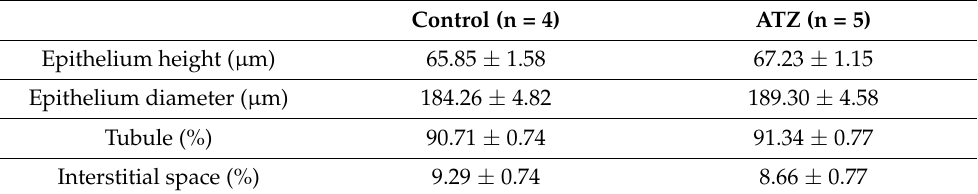
Table 6. The effect of atrazine on seminiferous tubule measurements at 6 months of age in the F1. No significant differences were found between the control and ATZ treatment for all parameters. Data are mean ± SEM. > 250 tubules were analyzed across > 5 sections per animal (n = 4 control, n = 5 ATZ). There were > 3 L per treatment.